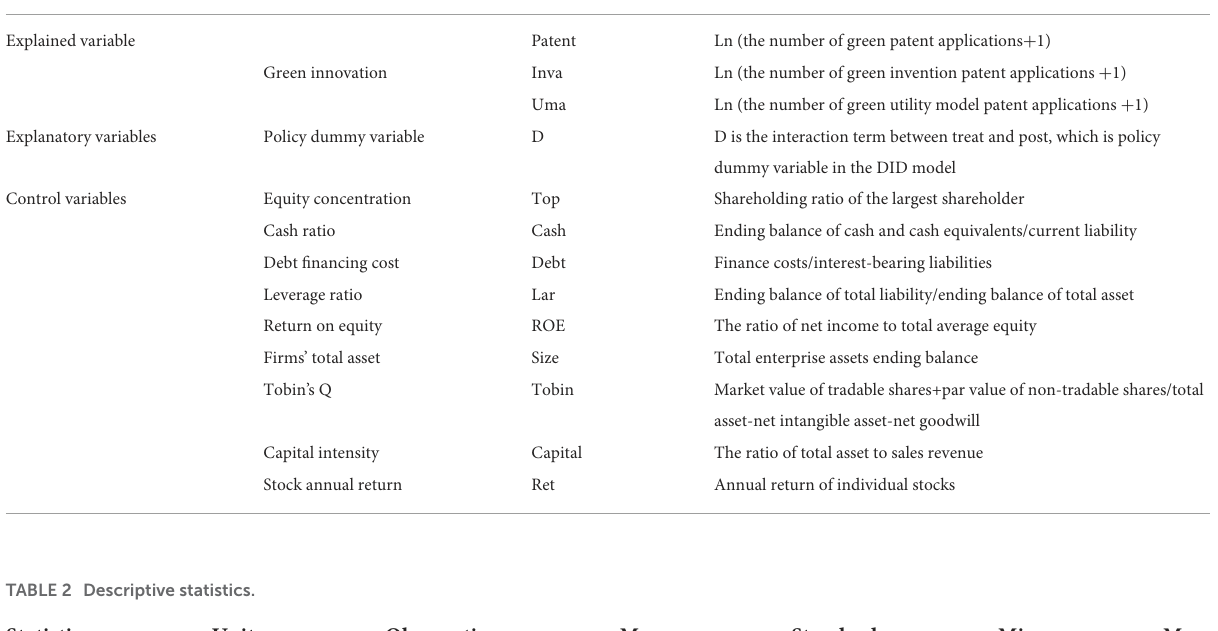
TABLE 1 Variable definitions.